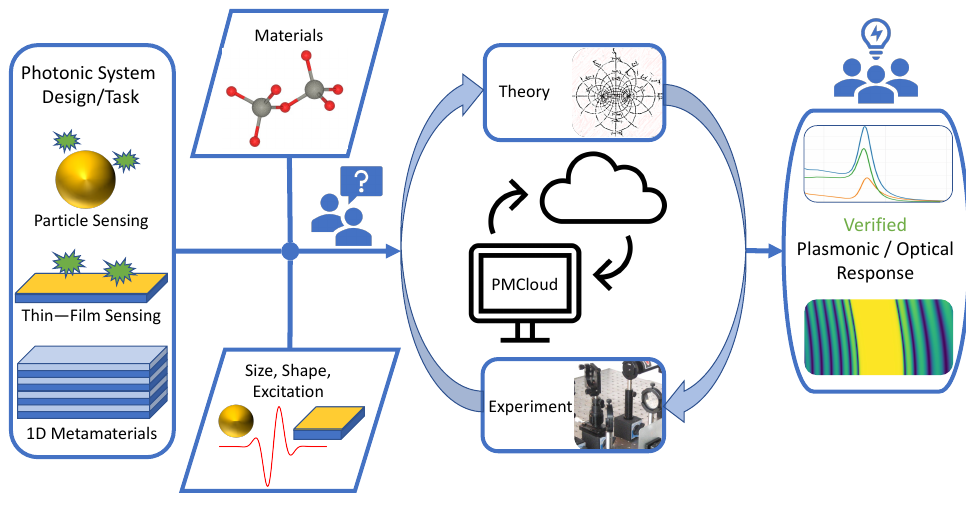
Figure 1. The Photonic Materials Cloud (PMCloud) is an easy-access platform used to design or cross-validate experimental setups and results. It allows the upload of experimental material data and a direct comparison to database- or theory-based materials. With the uploaded or generated data, the user can perform a series of standard scattering and thin-film optical experiments, predicting the optical response of various geometries, thereby helping to validate or modify experiments time